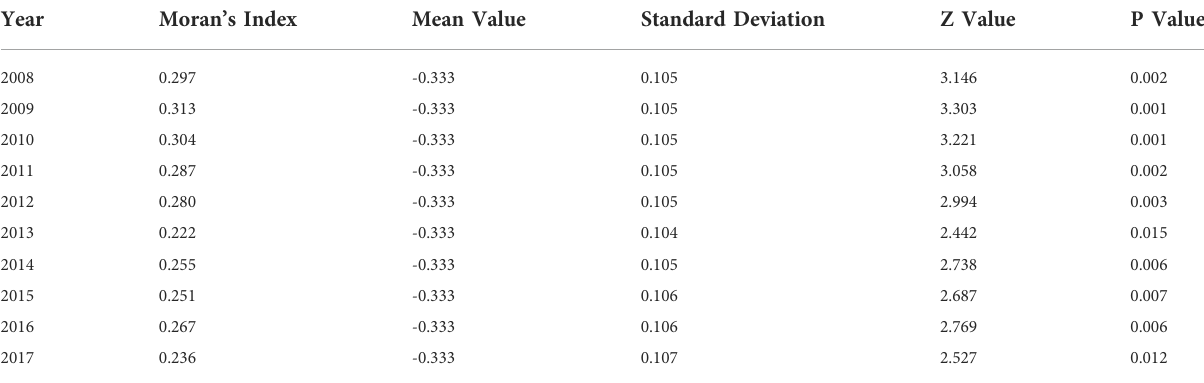
TABLE 2 Global Moran ’ s I and its signi fi cance test results of inbound overnight tourists in 31 provinces (cities, autonomous regions) of China from 2008 to 2017 Year Moran ’ s Index Mean